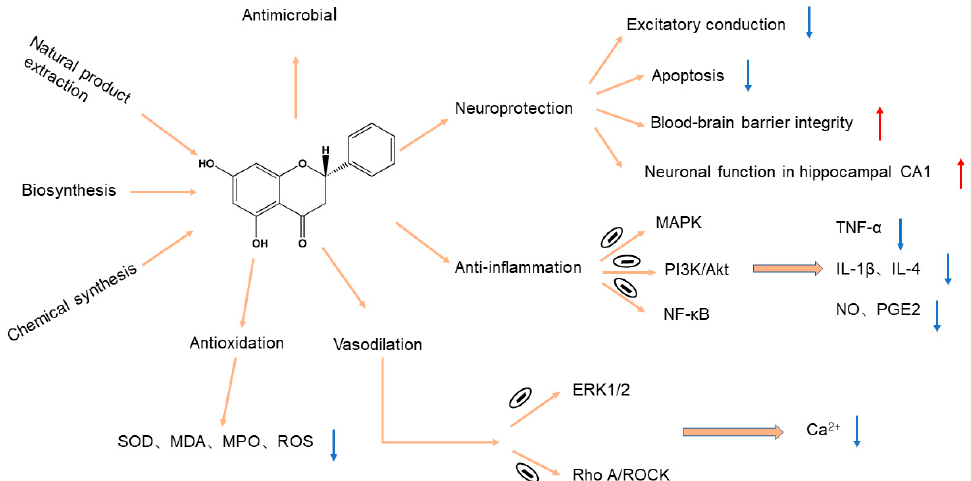
Figure 3. Pharmacological action and possible mechanisms of pinocembrin. Pinocembrin features a variety of pharmacological activities. This compound can inhibit the expression of pro-inflammatory factors by inhibiting mitogen-activated protein kinase (MAPK), phosphoinositide 3-kinase (PI3K) / AKT, and nuclear factor kappa B (NF- κ B) signaling pathways, thereby exerting anti-inflammatory e ff ects. Its vasodilation e ff ect is achieved by inhibiting the ERK1 / 2 and Rho-associated protein kinase (ROCK) signaling pathways and then downregulating calcium ion concentration. The neuroprotective e ff ects of pinocembrin mainly include the reduction in nerve excitability and neuronal apoptosis and enhances activity of cells in hippocampal CA1 region. Pinocembrin can down-regulate the contents of superoxide dismutase (SOD), malondialdehyde (MDA), myeloperoxidase (MPO), and ROS to achieve antioxidant e ff ects .